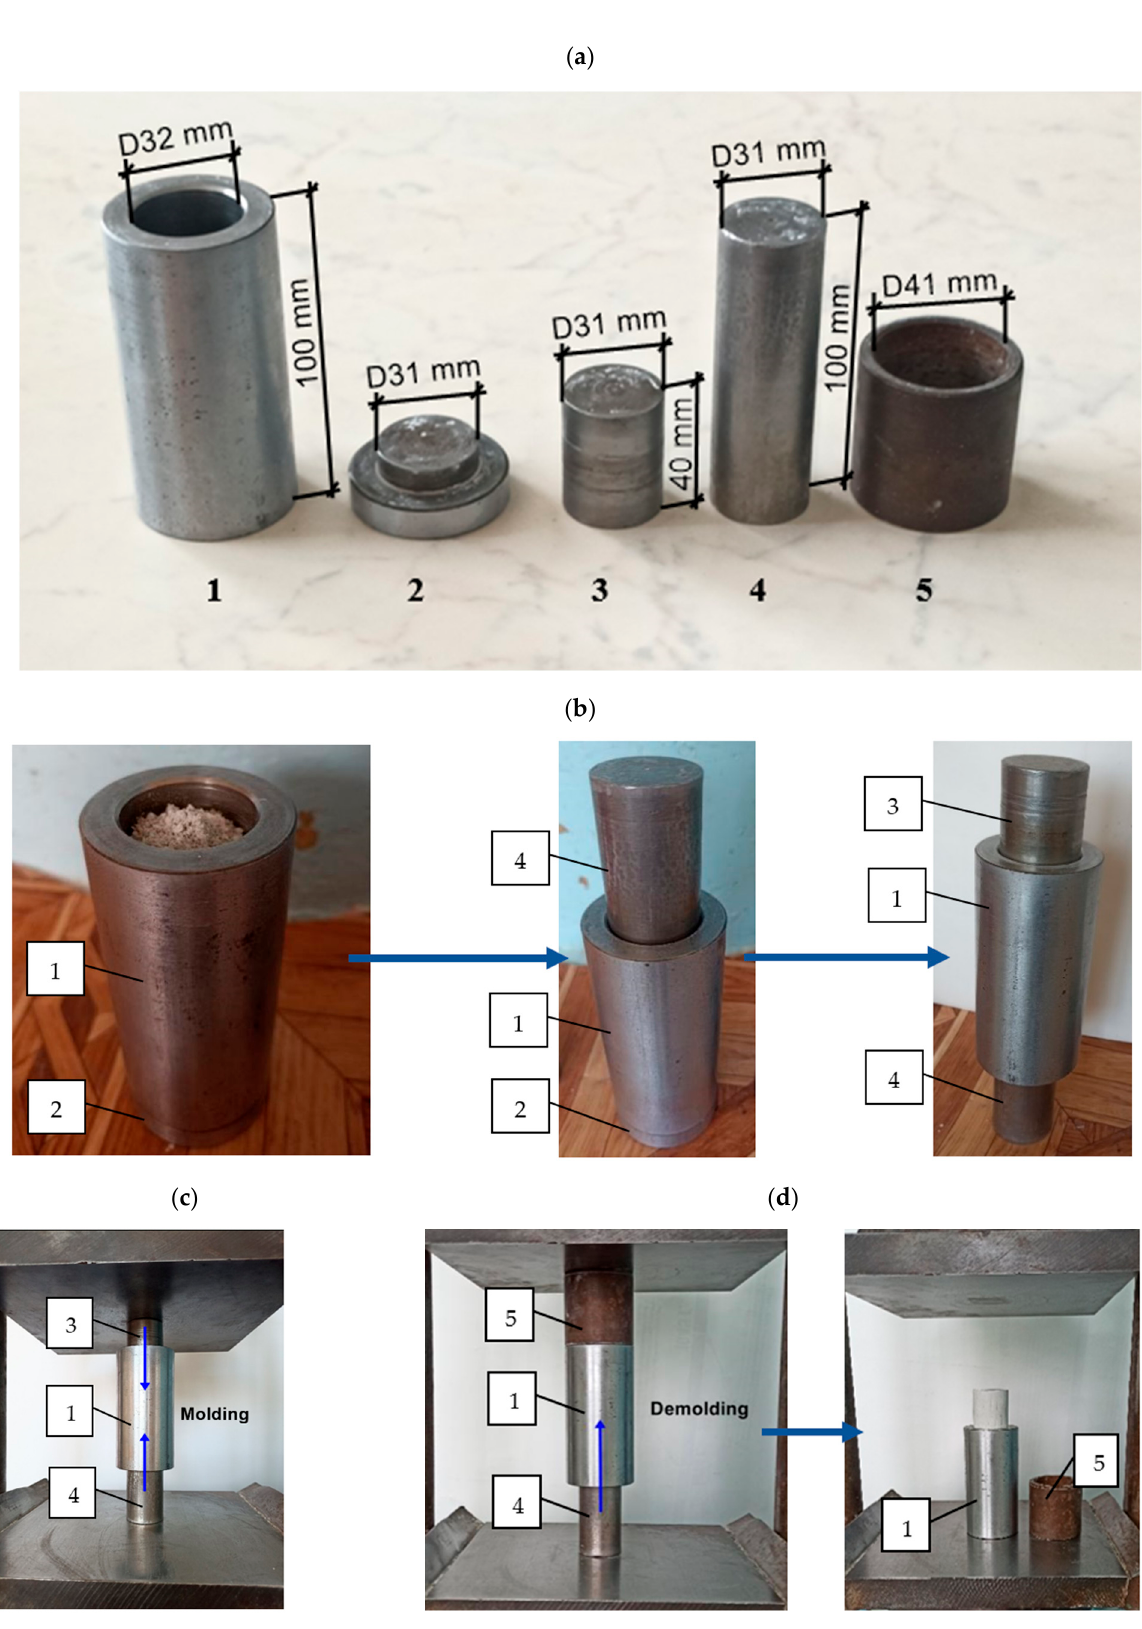
Figure 5. The sample preparation by semi-dry pressing method ( a ): 1—press-tool; 2—stand for fixing the molding mass; 3, 4—pistons for pressing; 5—cylinder for pressing out. ( b,c ) Molding stage; ( d ) demolding stage.